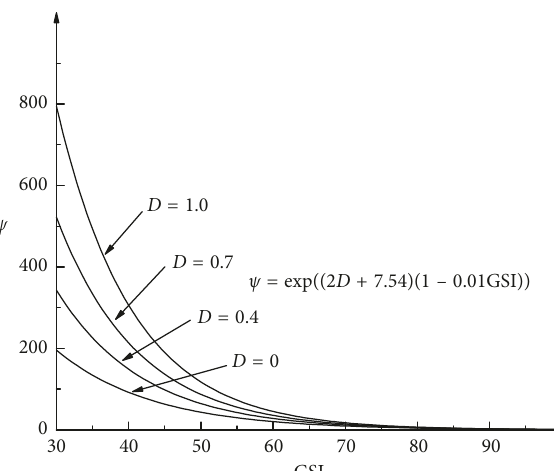
Figure 6: Trend of η .